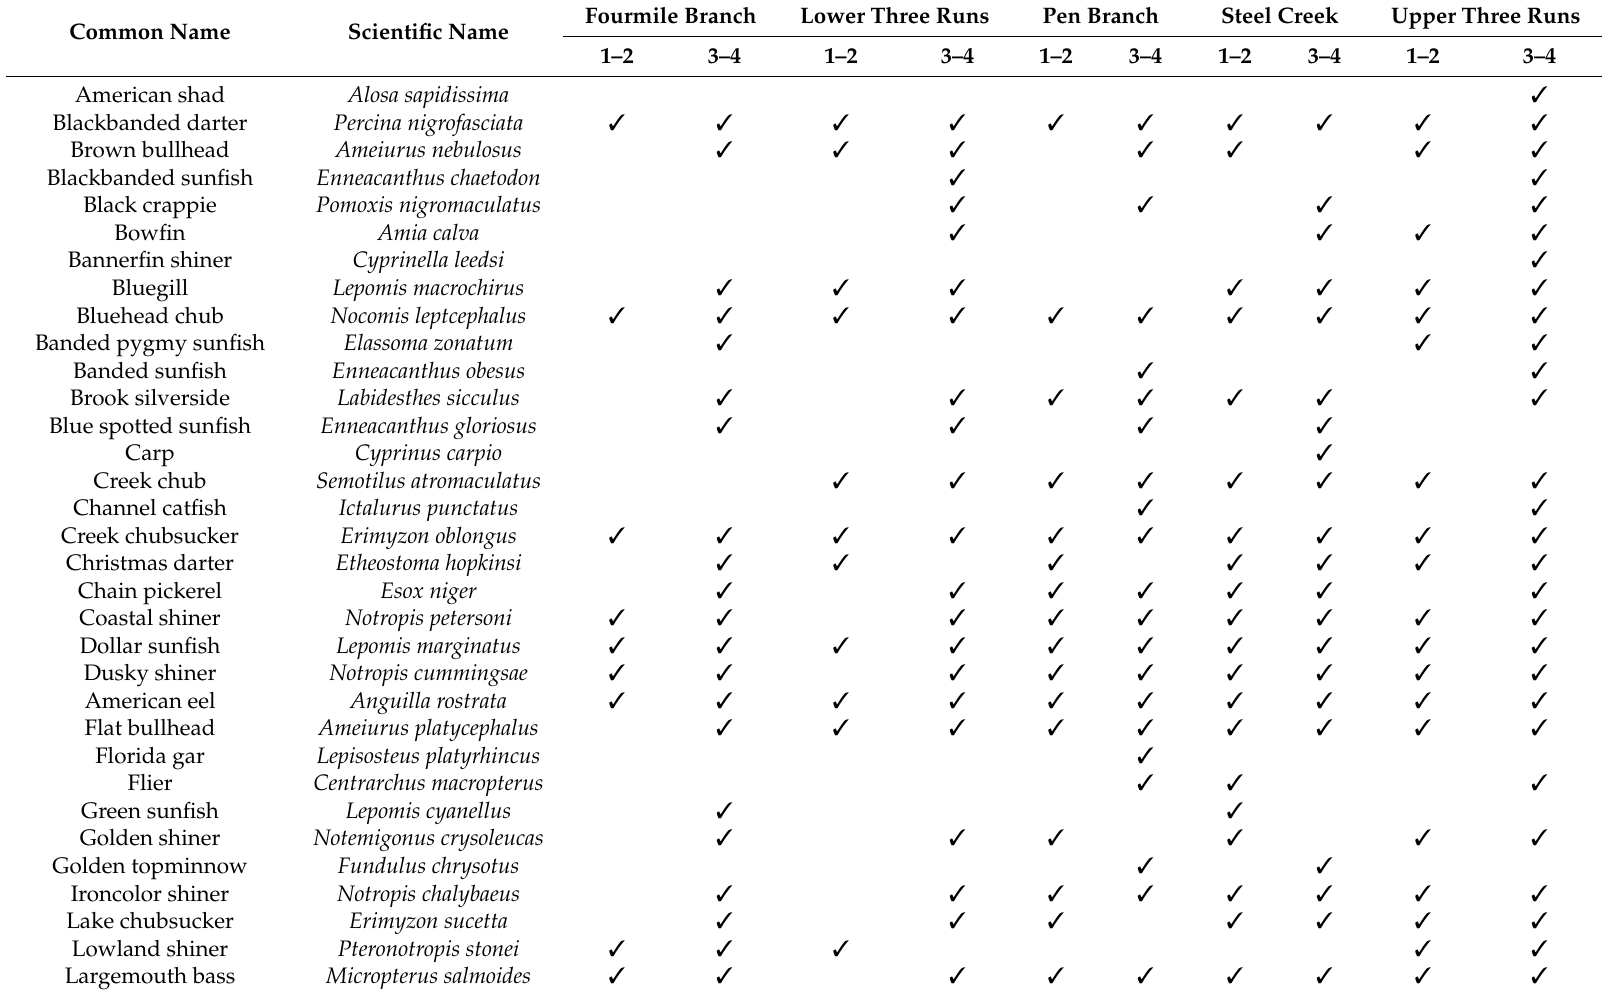
Table 1. Fish species collected from first and second order (1–2) streams and third and fourth order (3–4) streams on the Savannah River